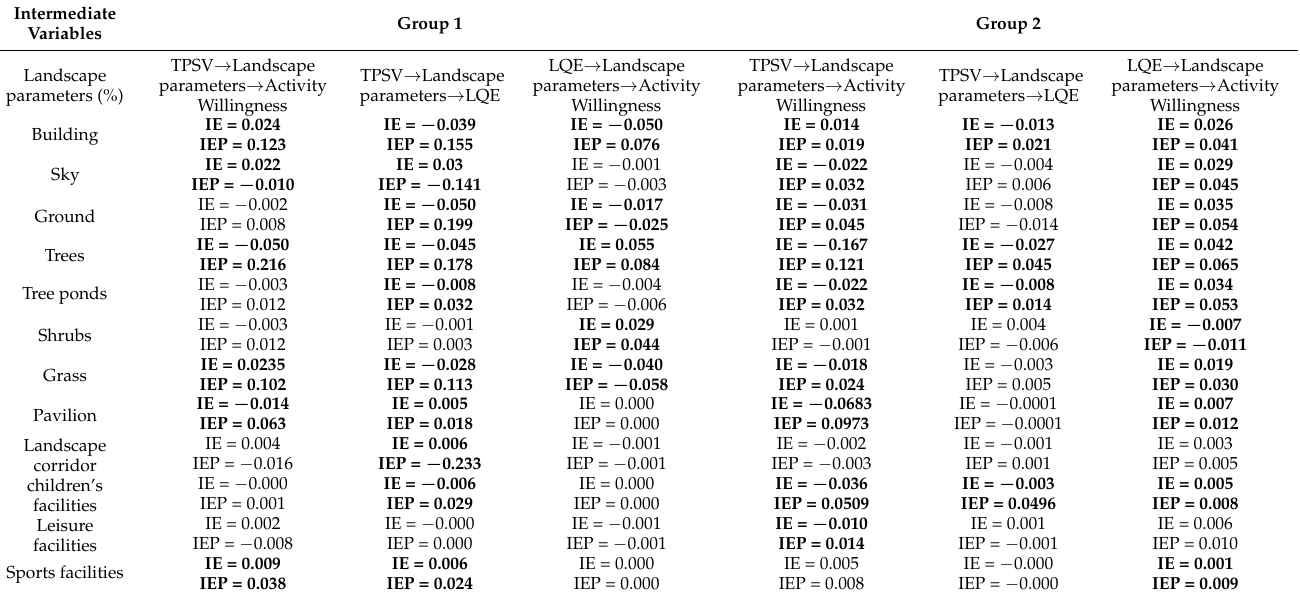
Table 13. Mediation of landscape configuration parameters among TPSV, LQE, and activity willing- ness (Note: Bolded fonts are significant paths of landscape configuration